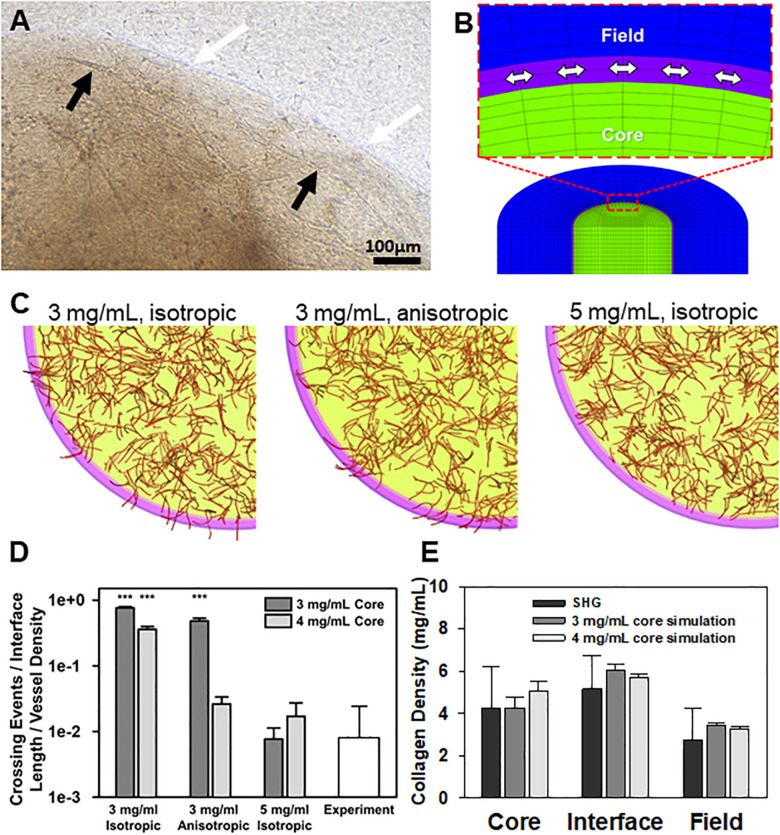
Simulations of neovessel growth in core-in-field models. (A) Top-view image of the interface of a CIF construct with microvessels growing along the tissue interface. White arrows point to the interface, black arrows point to microvessel being deflected along the interface. (B) Close-up of cut-view of cylindrical CIF geometry used in AngioFE. The core, interface, and field are colored in green, purple, and blue, respectively. Arrows indicate circumferential direction in the interface. (C) Simulations of vessel growth and behavior in CIF constructs with different interface densities and fibril organization. Visual results of the simulations for three different conditions of initial interface density (3 or 5 mg/mL) and fibril organization (anisotropic or isotropic) after 10 days of simulated culture. Cores are in light green, interfaces are in pink, fields are clear, and vessels are in red. (D) Log plot of predicted neovessel invasion across the interface for the three different simulated conditions, with an initial collagen concentration of either 3 or 4 mg/mL in the core. All groups are compared to the observed experimental value for microvessel-only constructs (white). Bars are mean ± SD, N = 4 for experiments, 10 for simulations. One-way ANOVA with Holm-Sidak post hoc analysis. ***P < 0.001 compared to experiments. There was an effect of interfacial matrix density on crossing regardless of core density. Further, simulated fibrils were more highly aligned than what was observed experimentally. (E) Validation of simulation mechanics determined by predicted final density after microvascular growth. Comparison of day 10 experimental (SHG) collagen densities after microvessel growth and contraction alongside predicted day 10 collagen densities from simulations. Simulations had an initial density in the core of 3 or 4 mg/mL. The initial interface and field densities were 5 and 3 mg/mL, respectively with isotropic fibrils for all simulations. The final densities predicted for each region by simulations are not different from those measured experimentally. One-way ANOVA performed on each region (core, interface, and field). Bars are mean ± SD. N = 15 (SHG) or N = 10 (simulation). P > 0.05.